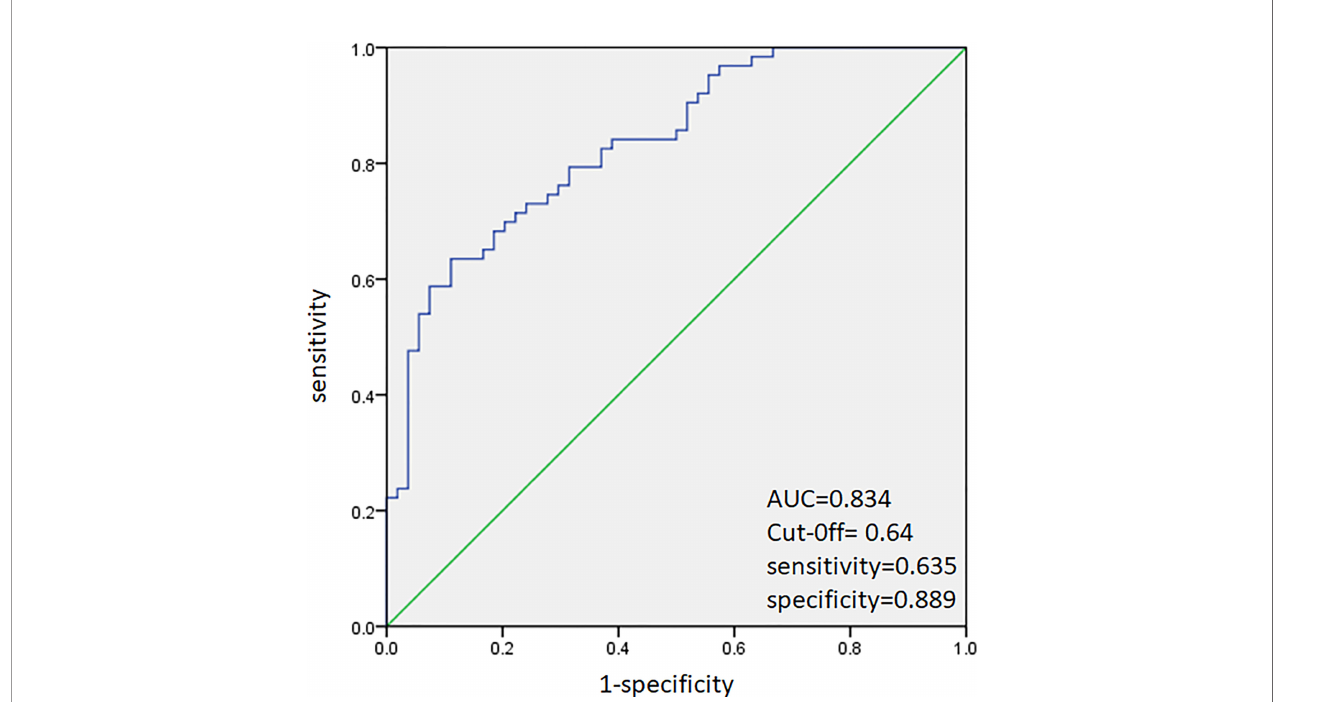
FIGURE 2 | Receiver operating characteristic curve analysis for prediction of central lymph node metastases using the multivariate model in HT patients.